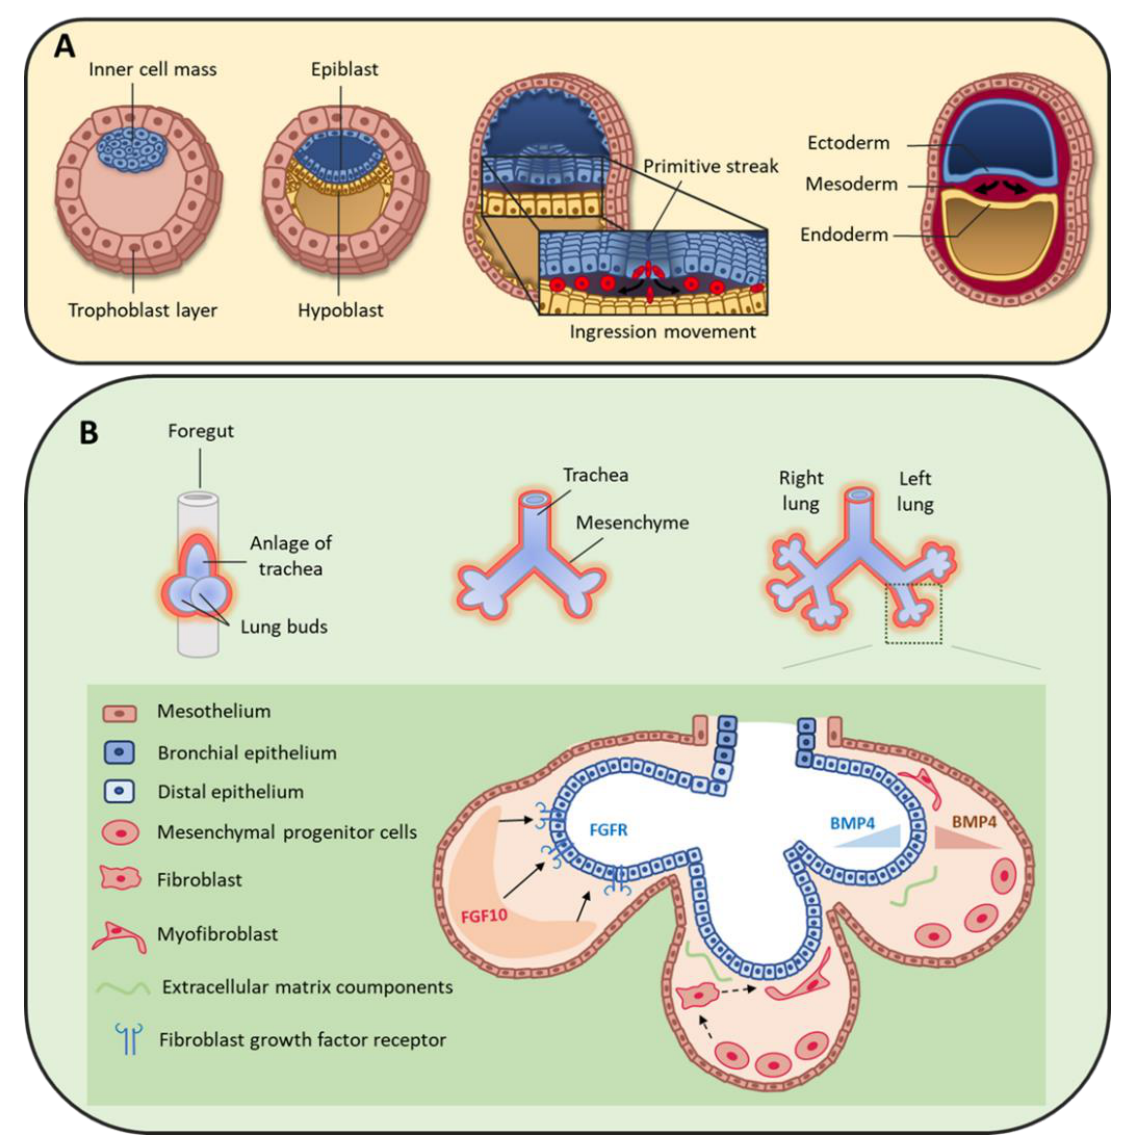
Figure 2. ( A ) During early human embryo development, the inner cell mass differentiates and becomes organized in the epiblast and hypoblast layers. Primitive streak formation leads to an ingression movement of epiblastic cells that elongate and detach from each other via a critical epithelial–mesenchymal transition [31]. This results in the formation of the three germ layers: ectoderm, mesoderm and endoderm. ( B ) On day 22, the foregut forms a ventral outgrowth leading to the formation of larynx and trachea in its proximal part, and lung buds in the distal part. Bifurcation and splitting of the lung buds give rise to the future right and left lungs. These structures grow ventrally to caudally through the surrounding mesenchyme. Mesenchymal progenitor cells secrete many factors, including fibroblast growth factor 10 (FGF10) that interacts with fibroblast growth factor receptor (FGFR) expressed by distal epithelial cells. Moreover, some cytokines, such as bone morphogenic protein 4 (BMP4), are secreted by both epithelial and mesenchymal cells.